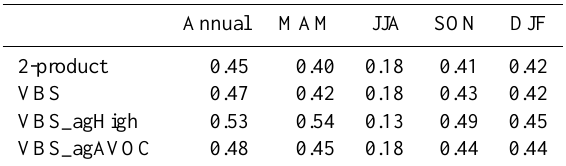
Table 5. Coefficients of determination ( r 2 ) of IMPROVE measure- ments versus simulated total